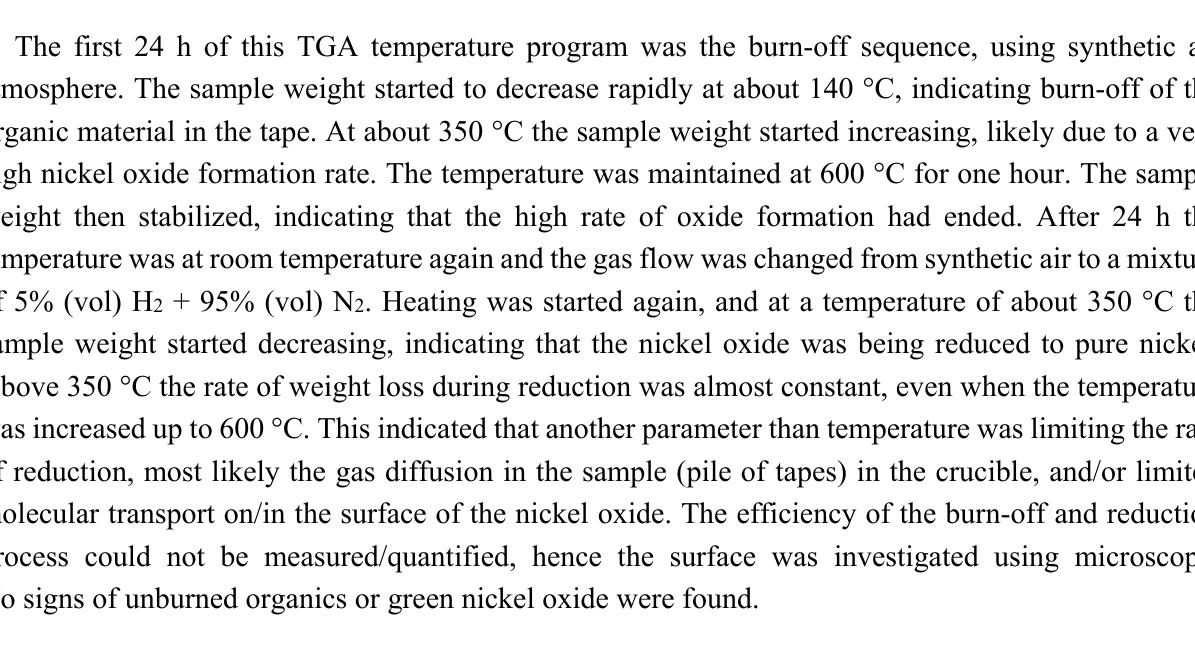
Figure 4. Thermogravimetric analysis of tape cast tape burn-off and